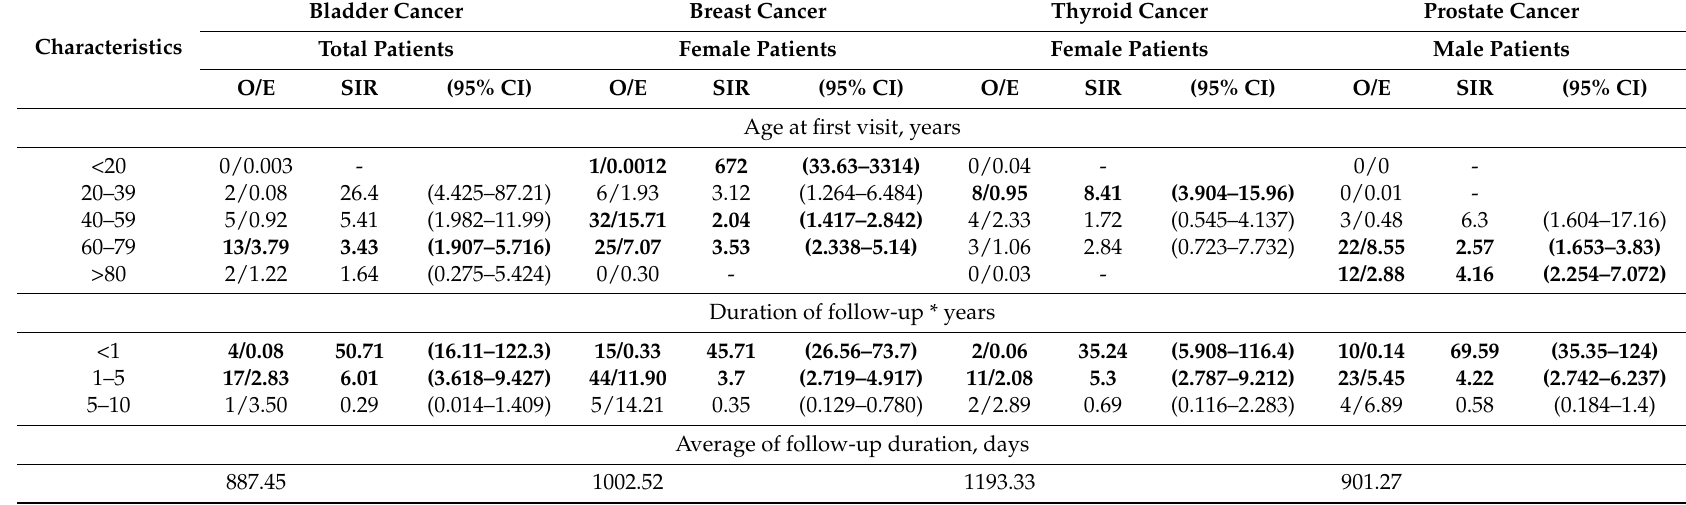
Table 4. Standardized incidence ratios for selected cancers in vitiligo patients, stratified by age at the date of a first-time diagnosis and duration of follow-up.